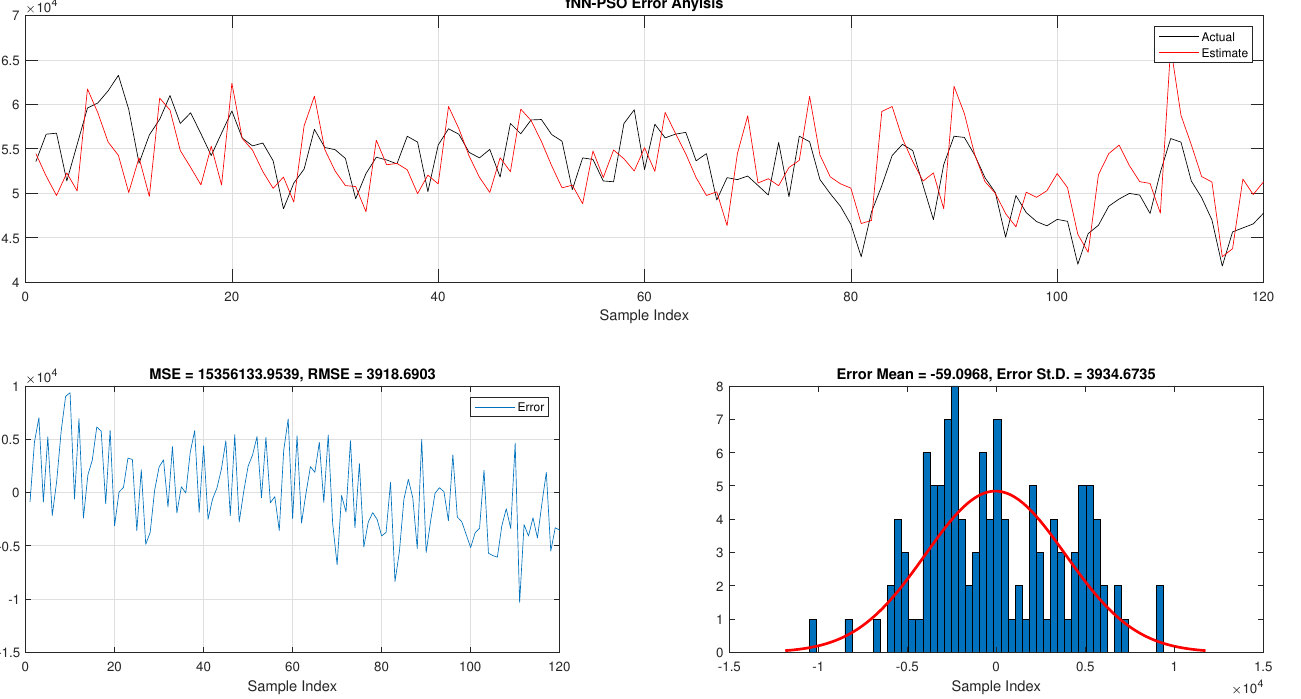
Figure 17. Error analysis of the total daily load consumption with fNN-PSO best